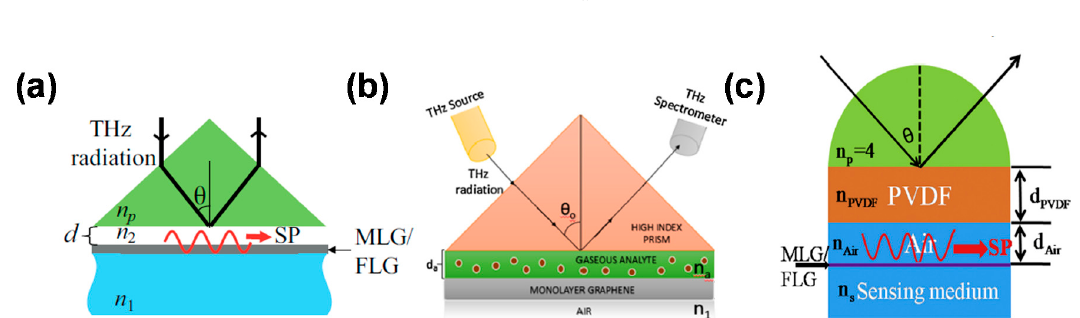
Figure 3. Surface plasmon sensor structure based on Otto or Kretschmann configuration. ( a ) Surface plasmon (SP) supported by doped graphene sheets at THz frequencies with attenuated total reflection (ATR) via the Otto geometry. Reproduced with permission from [30] © 2012 AIP Publishing. ( b ) SPR- based gas sensor in THz frequency with the Otto configuration. Reproduced with permission from